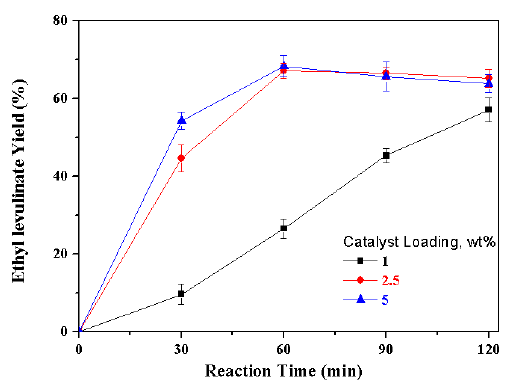
Figure 4. Effect of catalyst dosage on EL yield. Reaction conditions: FA 1 g, ethanol 19 g, temperature 423K.